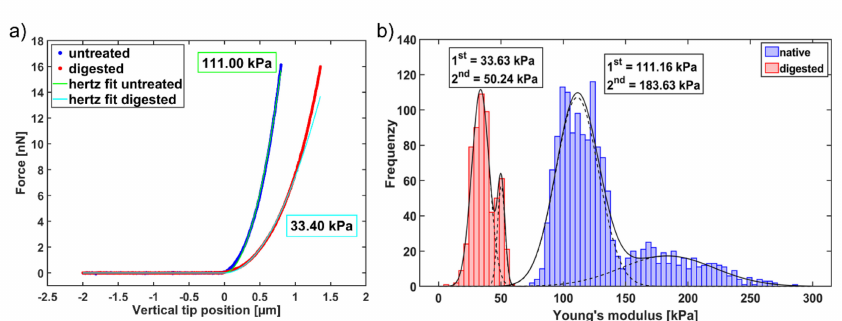
Figure 4. ( a ) Illustration of two representative force-indentation curves obtained by IT-AFM with the corresponding fits of the Hertz model. The blue line represents a force-indentation curve of native bovine cartilage, where the Hertz fit (green line) determines a Young’s modulus of 111.00 kPa. In contrast, the red line represents a force-indentation curve measured on the same cartilage, but after a 5 min digestion with 100 µ g / mL collagenase. The Hertz fit (cyan line) determines a reduced Young’s modulus of 33.40 kPa. ( b ) Young’s modulus distributions of a native cartilage sample (blue distribution) and the distribution obtained from the same sample after a collagenase treatment with 100 µ g / mL (red distribution). The bimodal fits to the histograms (solid black lines) reveal a softening of the tissue due to the collagenase digestion of about 70% for the 1st peak (from 111.16 kPa to 33.63 kPa) and about 73% for the 2nd peak. The dashed lines in the histograms represent the two individual Gauss distributions of the corresponding bimodal distribution.